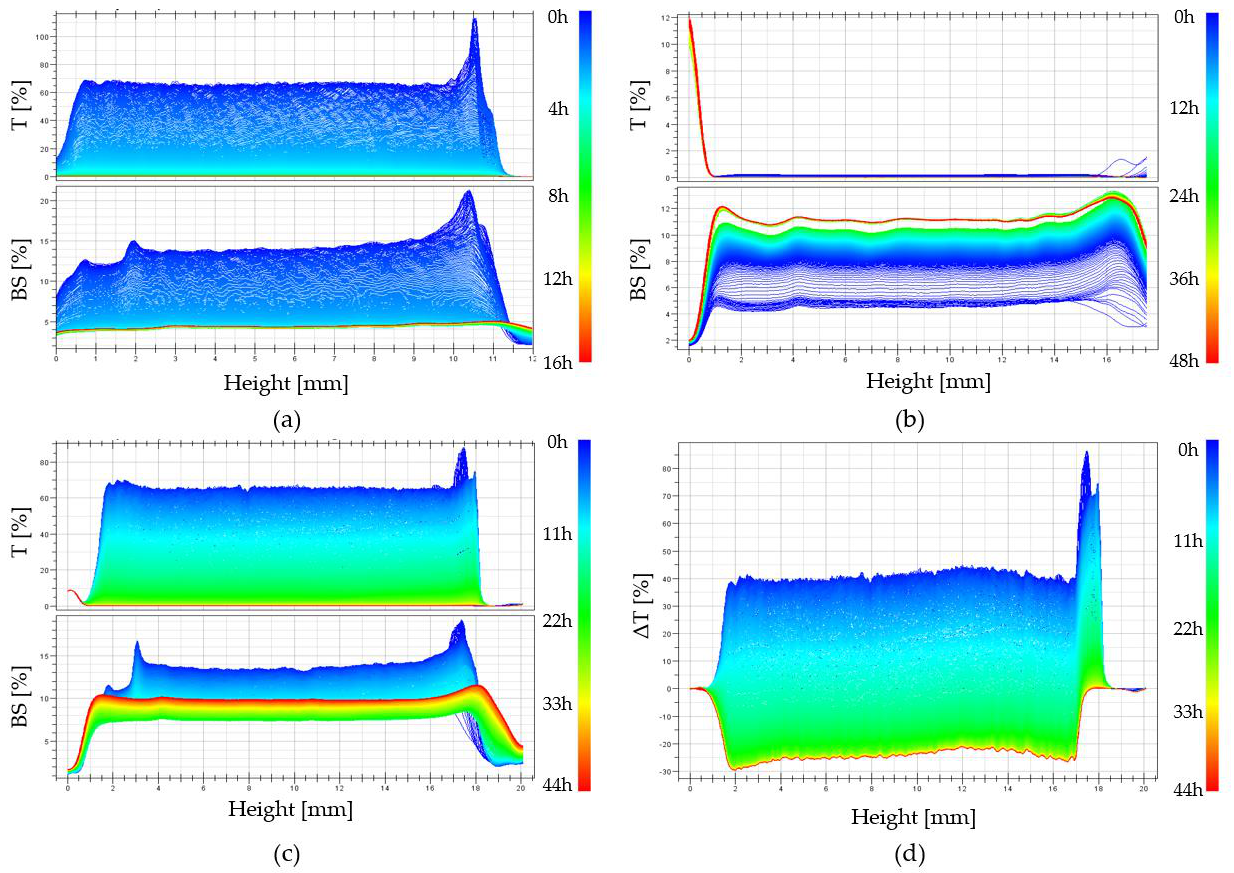
Figure 4. The intensity curves of the transmittance (T) [%] and the backscattering (BS) [%] reflected from the suspended particles obtained for the colloidal systems of chitosan acetate containing ( a ) disodium glycerophosphate, ( b ) calcium glycerophosphate, and ( c ) magnesium glycerophosphate. ( d ) Differential transmittance signal curves ∆ T = T − Tp [%] obtained for a colloidal system of chitosan acetate containing magnesium glycerophosphate.